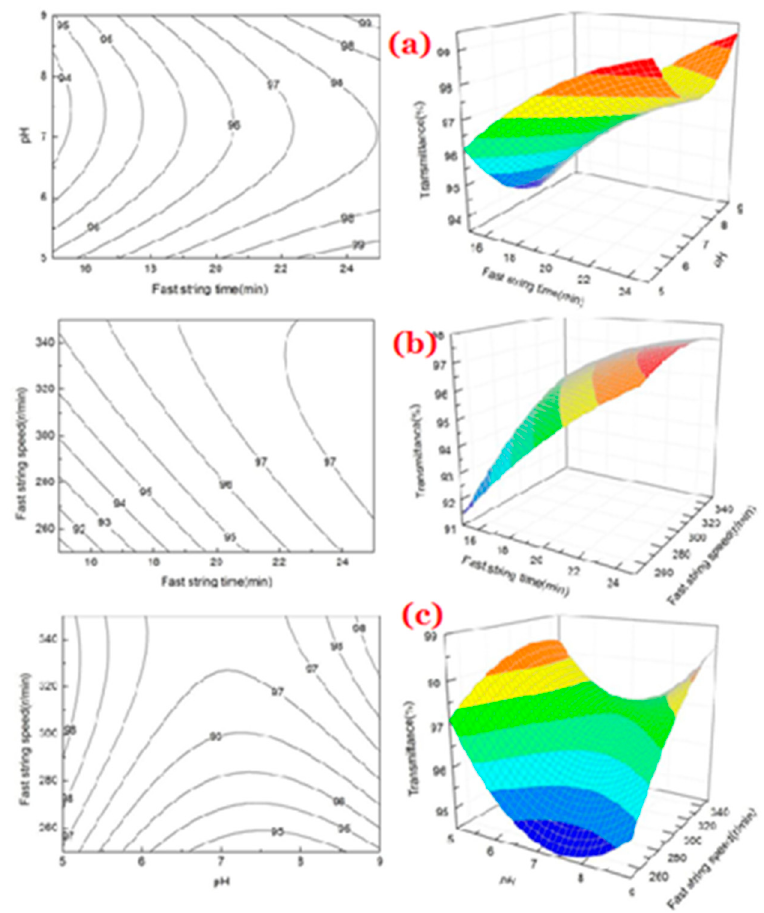
Figure 9. Response surface plotted and contour map of ( a ) fast stirring time and pH, ( b ) fast stirring time and fast stirring speed, and ( c ) pH and fast stirring